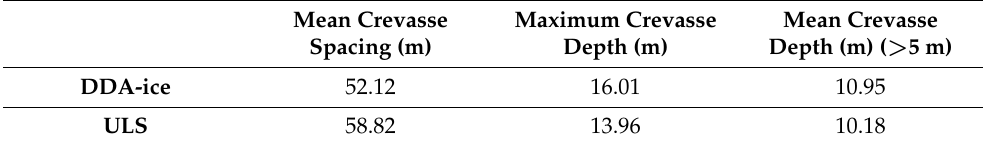
Table 6. Crevasse spacing and depths for Negribreen evaluation profile “segment 23 (RGT 594) 5 August 2019”. Comparison of results from ULS airborne laser altimeter data and DDA-ice applied